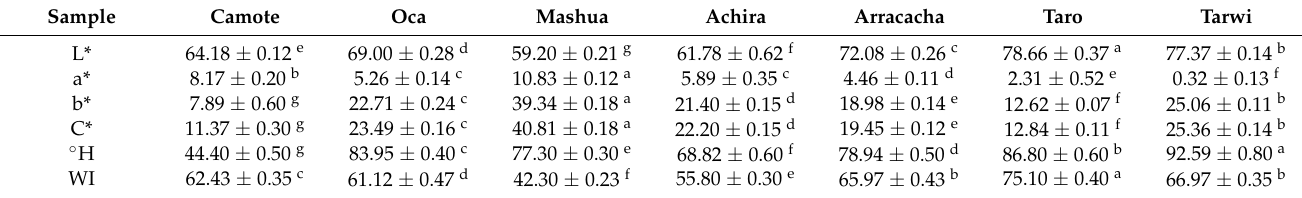
Table 2. Color properties of andean crops